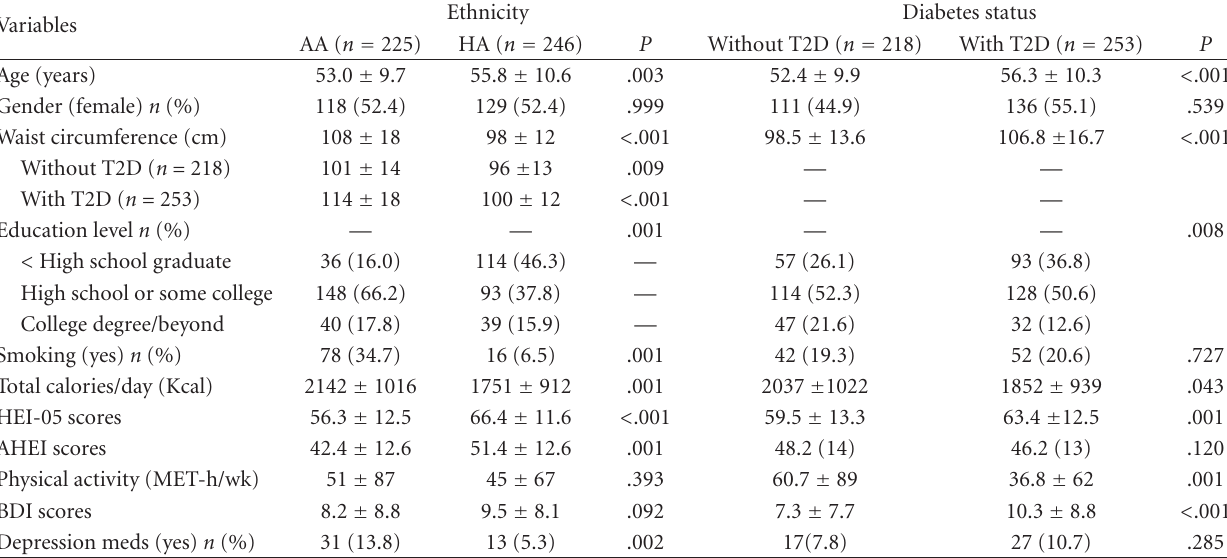
Table 1: General characteristics of the participants by ethnicity and diabetes